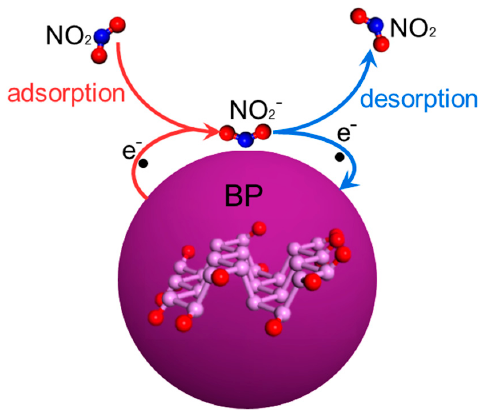
Figure 9. Schematic drawing of the gas-sensing mechanism of the BP sensor to NO 2 .